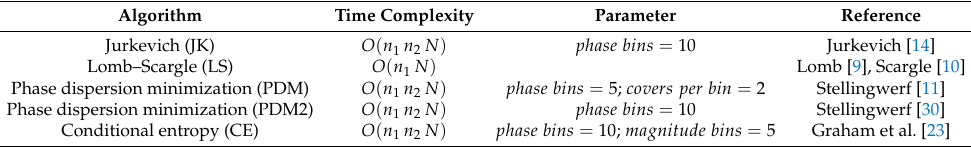
Table 5. Theoretical time complexity, parameters and references of each